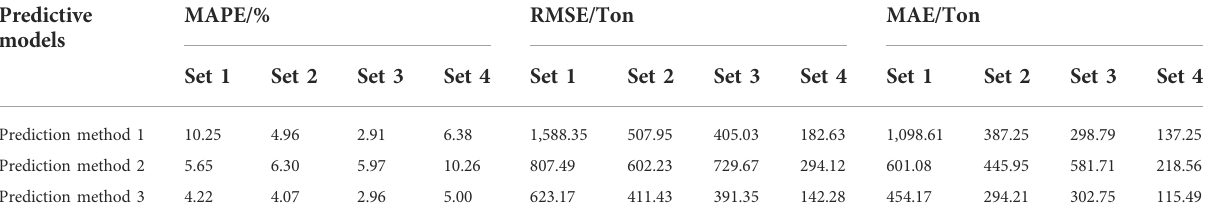
TABLE 5 Comparison of cold load prediction